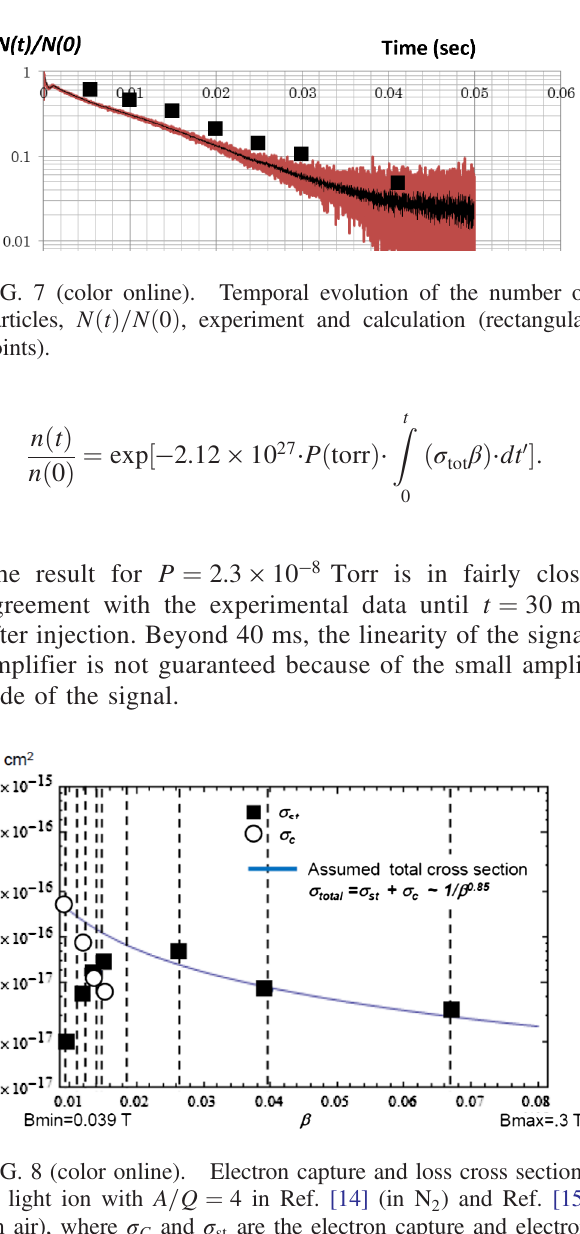
FIG. 6 (color online). Top: reference gate signal for V bottom: bunch signals around the end of acceleration cycle of 50 msec.